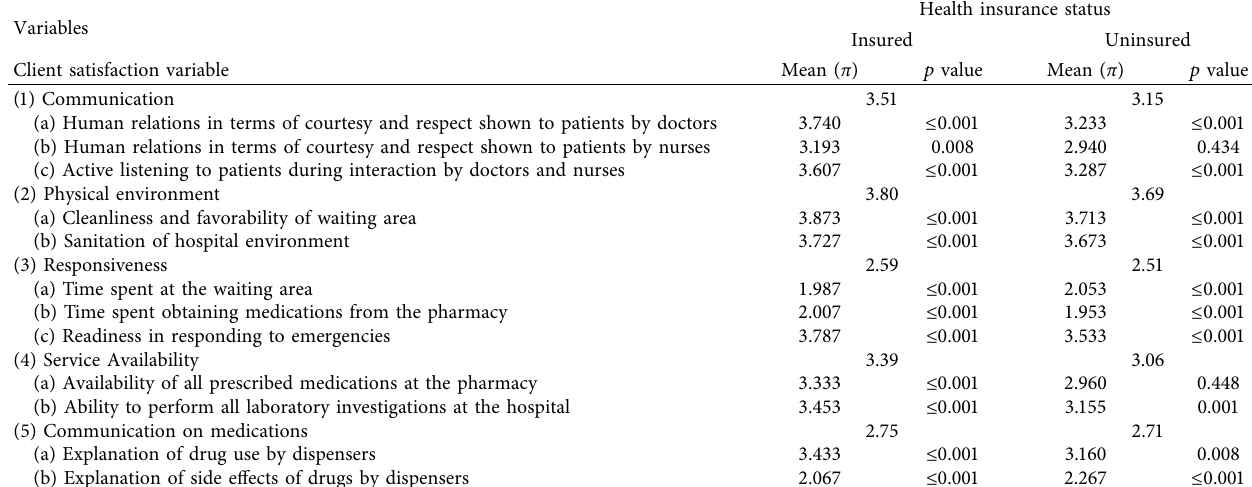
Table 2: Client satisfaction with health service delivery under